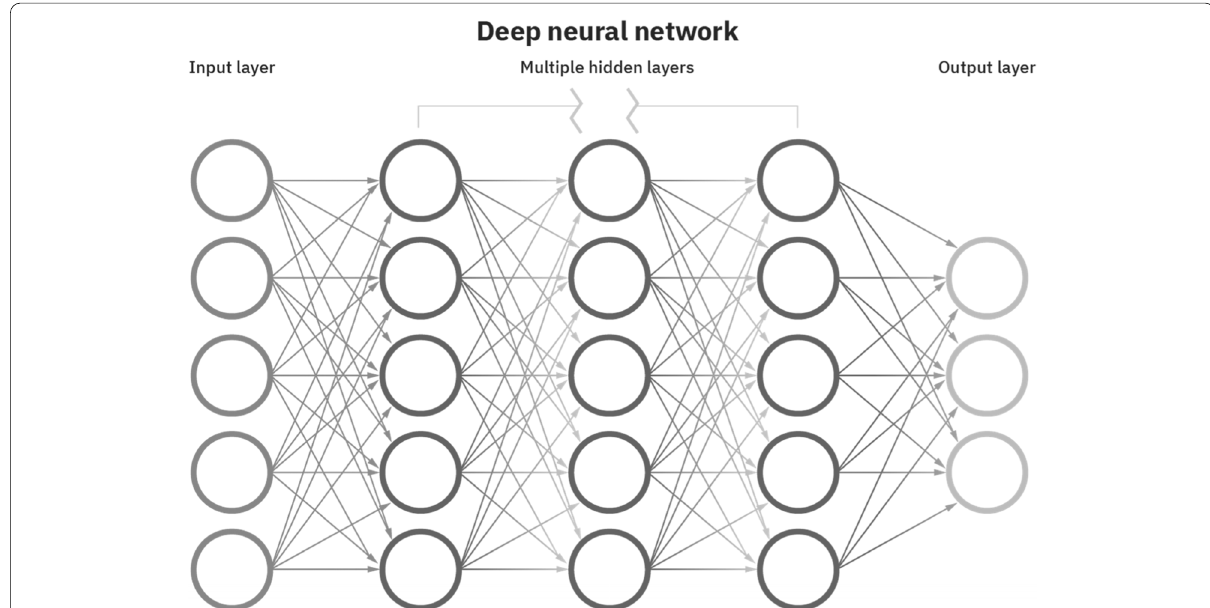
Fig. 2 A stylized deep neural network depiction. Source: https:// www. ibm. com/ cloud/ blog/ ai- vs- machi ne- learn ing- vs- deep- learn ing- vs- neural- netwo